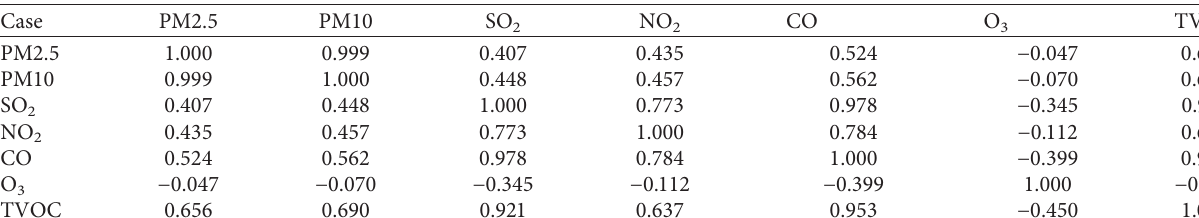
Table 1: Cluster approximation matrix of pollution